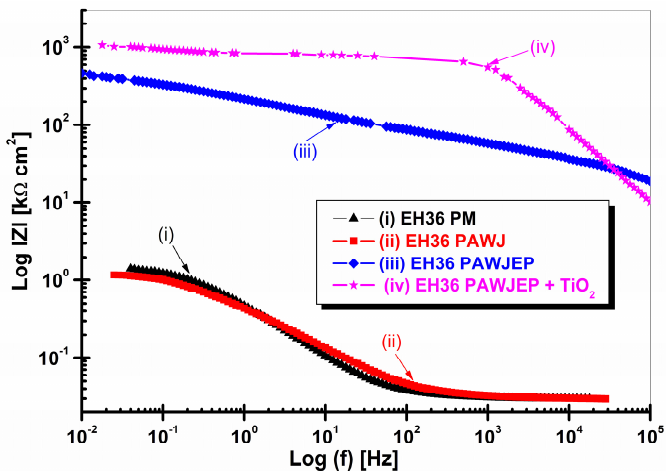
Figure 11. Electrochemical impedance spectroscopy diagrams in Bode representation as impedance modulus Z vs. log frequency for: (i) EH36PM without protective coating used like parent material, (ii) EH36PAWJ without protective coating, (iii) EH36PAWJEP coated with polymeric primer and (iv) EH36PAWJEP + TiO 2 coated with nanocomposite polymeric primer with dispersed TiO 2